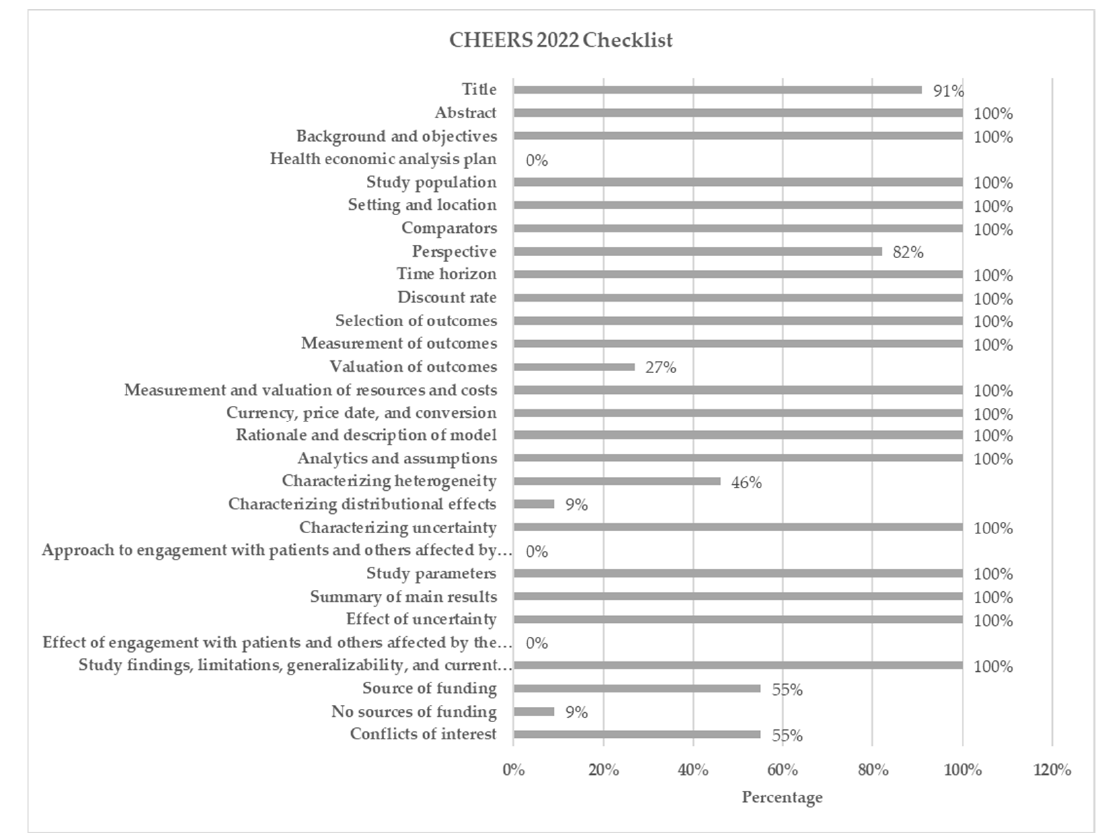
Figure 3. Quality of reporting results based on the 2022 CHEERS checklist